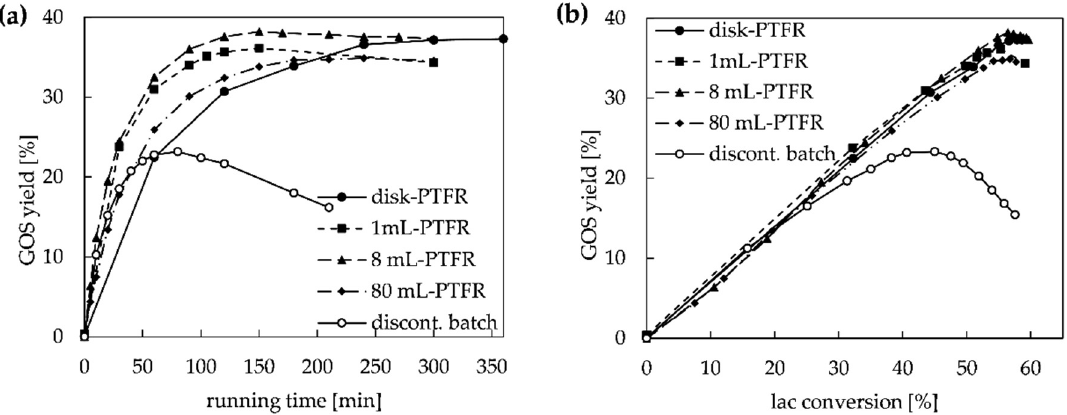
Figure 4. Comparison of the GOS yield obtained with the free enzyme in a discontinuous batch reactor and the immobilized enzyme with semi-continuous configuration in PTFRs, flow for disk and 1 mL-PTFR was 0.5 mL min − 1 , for 8 mL-PTFR 10 mL min − 1 and for 80 mL-PTFR 20 mL min − 1 (ILC = 100 g L − 1 ): ( a ) GOS yield vs. experimental running time; ( b ) GOS yield compared to lactose conversion.